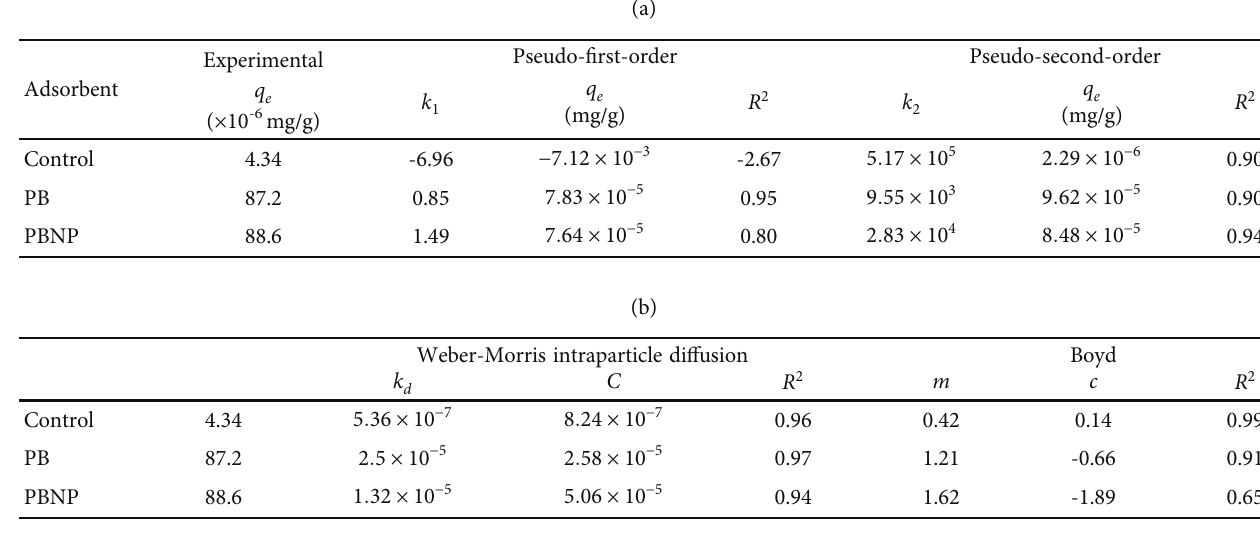
Table 1: Parameters obtained from the kinetic models of MB dye unto sponges.